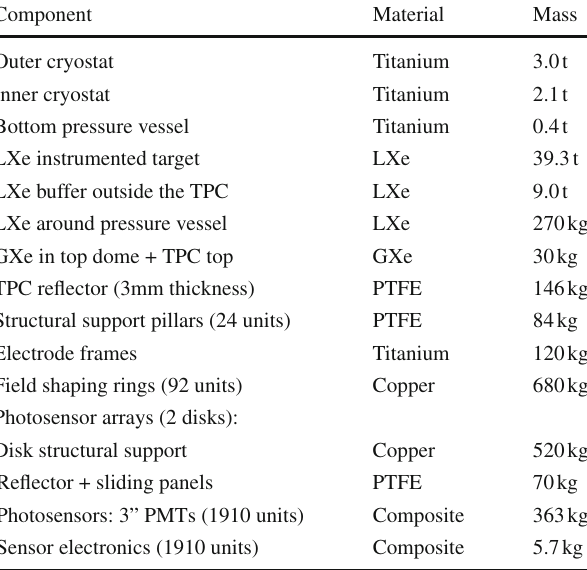
walled cryostat surrounded by an instrumented water tank to shield it from the environmental radioactivity and to record the passage of cosmic muons and their secondaries as well as for neutron thermalization.